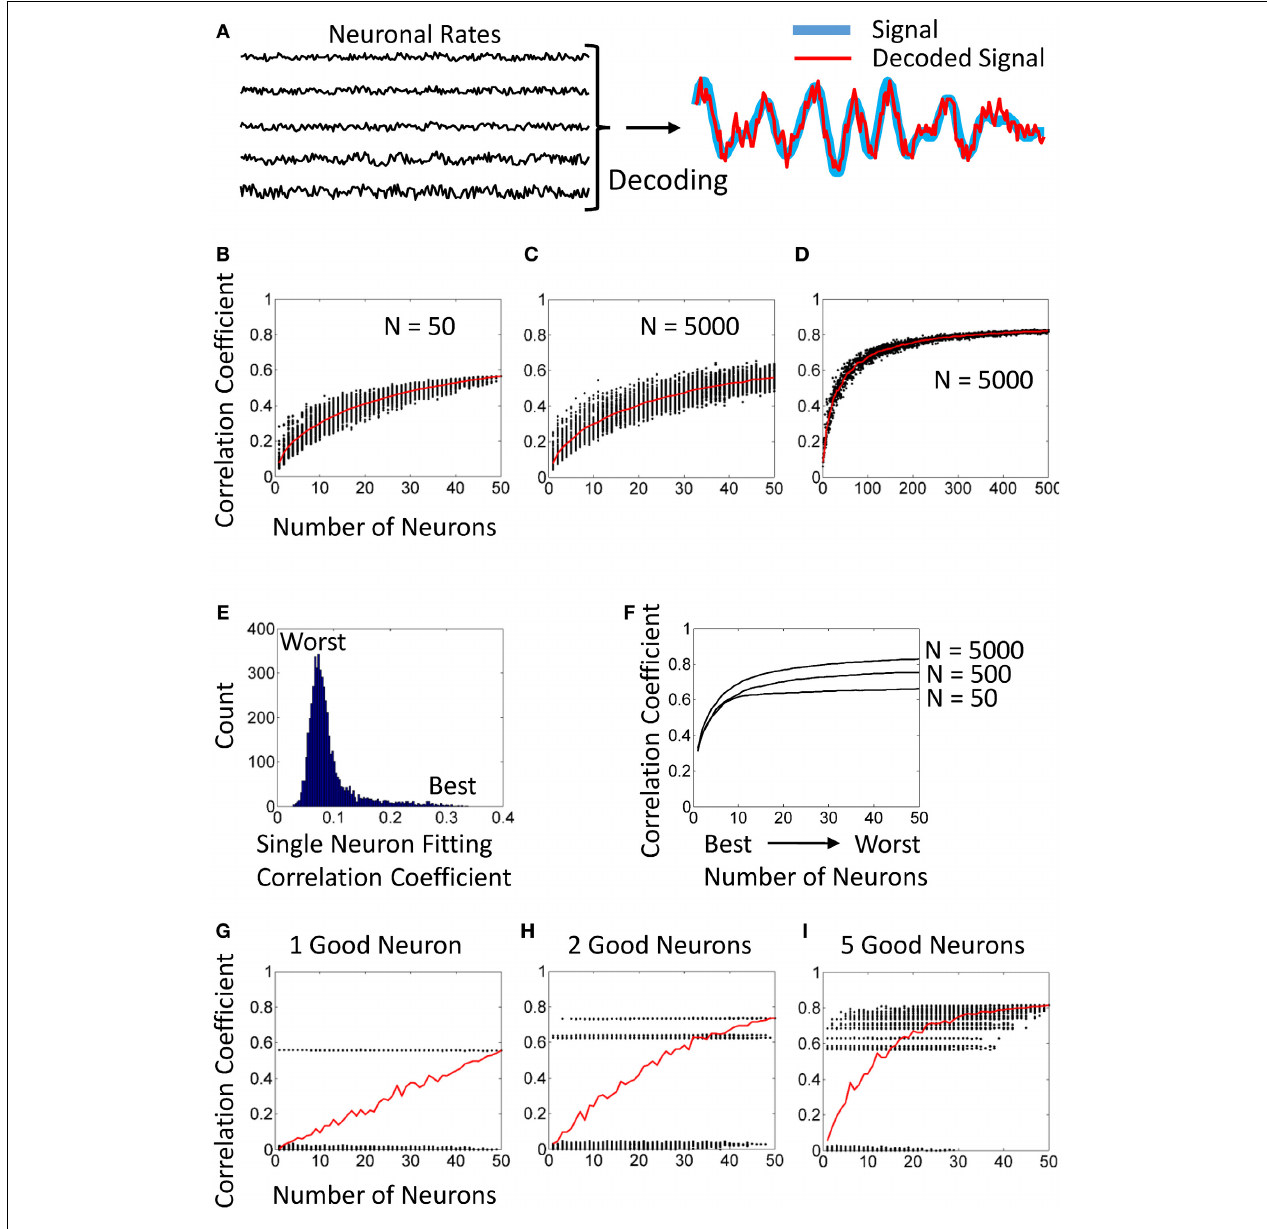
FIGURE 1 | Simulated NDCs. (A) Simulated neuronal rates (left) and their utilization for decoding (right). (B) An NDC generated from a population of 50 neurons. Each dot corresponds to a randomly drawn neuronal subpopulation. (C) An NDC generated from a population of 5000 neurons with the same statistical distributions of tuning characteristics as for 50 neurons in panel (B) . (D) The same analysis as in (C) for subpopulation sizes from 1 to 500. (E) Distribution of